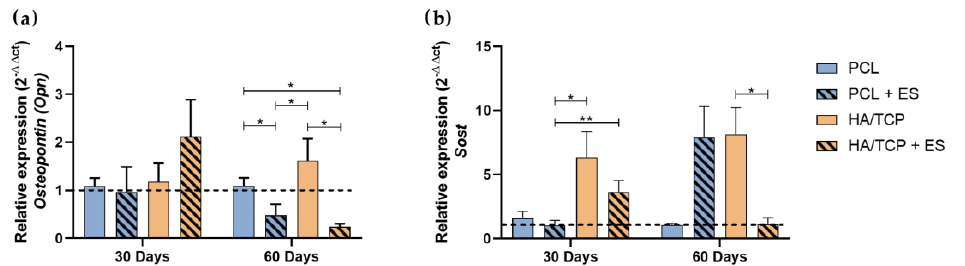
Figure 5. Relative gene expression of ( a ) Osteopontin (Opn) and ( b ) Sost (2 − ∆∆ ct ). Results were expressed as mean ± standard error of the mean (significance levels were established in * p < 0.05, ** p < 0.01).